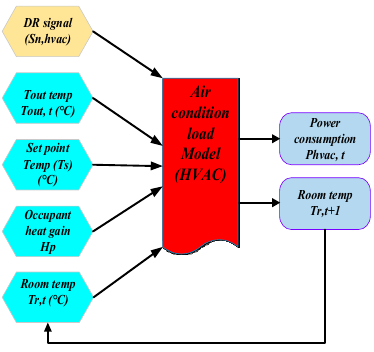
Figure 2. Flowchart of the AC load model.